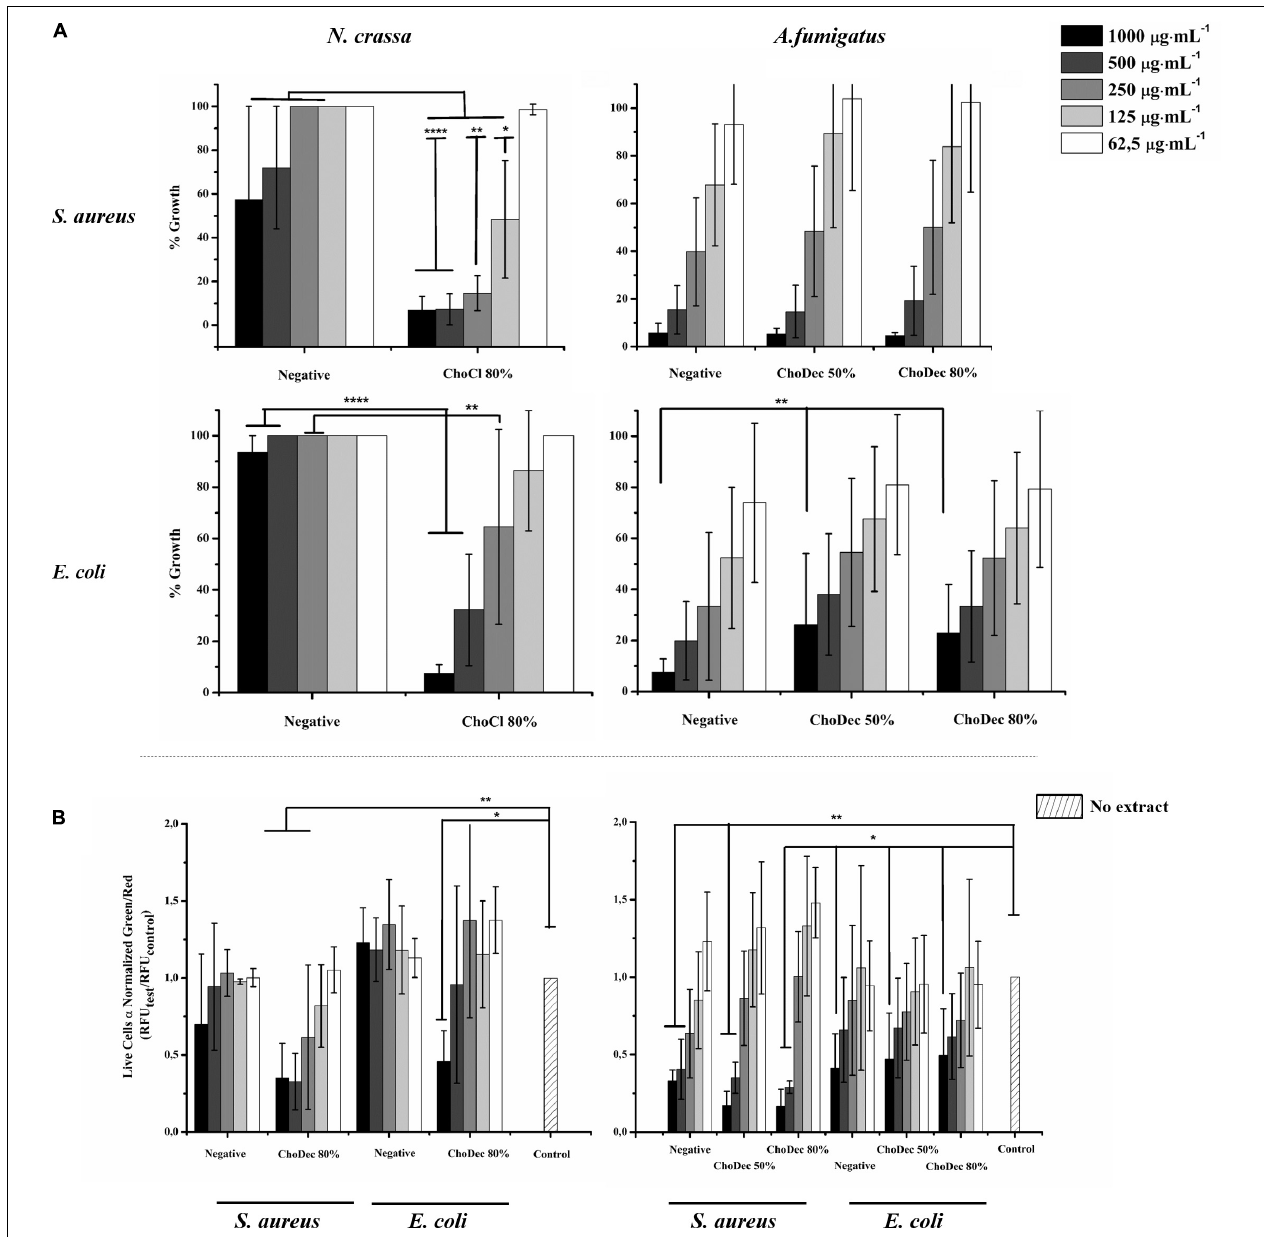
FIGURE 3 | N. crassa and A. fumigatus crude extracts depict antibacterial activity against S. aureus and E. coli . Cell viability measured by MTT assay of extracts derived from cultures grown in media with or without (i.e., negative) supplementation (A) . Quantification of bacterial viability through the normalized green/red ratio (i.e., SYTO9 (green, live cells)/PI (red, dead cells) staining) (B) . Statistically significant differences are depicted; * p ≤ 0.05, ** p ≤ 0.01, **** p ≤